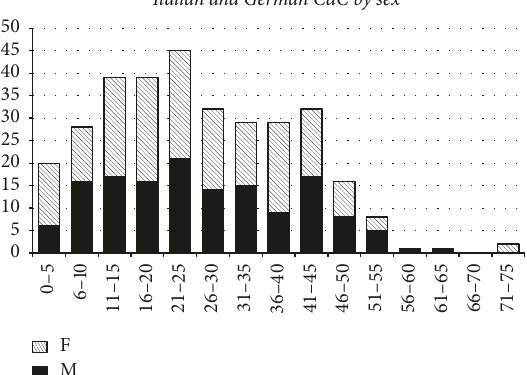
neoplasia was diagnosed and a fifth patient who developed a cholesteatoma (Table